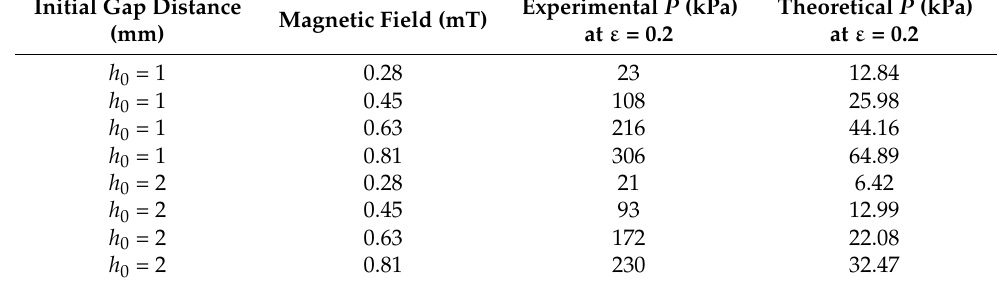
Table 1. Test conditions and the calculated and experimental values of compressive stress.